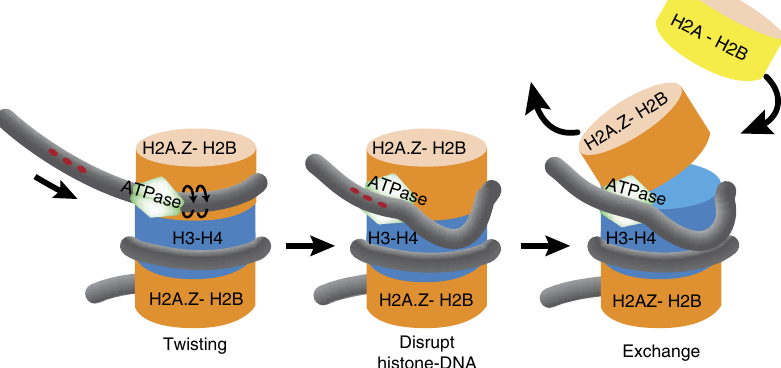
Figure 7 | INO80 translocates along DNA at the H2A–H2B dimer interface to displace DNA and promote H2A.Z exchange. A model showing DNA translocation by INO80 close to the DNA entry site of nucleosomes for nucleosome mobilization and histone dimer exchange. Translocation persistently destabilizes dimer–DNA interactions and promotes the exchange of H2A.Z–H2B Methods Enzyme purification . INO80 and ISW2 complexes were purified from Saccharomyces cerevisiae strains S288C 70 and YTT480 (ref. 71), respectively. Briefly, double FLAG epitope tags were inserted at the 3 0 -end of the INO80 and ISW2 genes and the complexes were purified by immunoaffinity chromatography using ANTI-FLAG M2 Affinity Gel (Sigma) and eluted with FLAG peptides. Complex purity and integrity was determined by analysing samples on 4–20% SDS–polyacrylamide gels. Enzyme complexes were tested for nucleosome binding, remodelling and nucleosome-stimulated ATP hydrolysis activity 36 . Nucleosome reconstitution . Mono-nucleosomes (‘70N0’ or ‘0N70’, N ¼ nucleosome core particle with 147bp of 601 DNA and number indicated length of extranucleosomal DNA) were assembled at 37 (cid:2) C by salt dilution with 7–10 m g of recombinant Xenopus laevis octamers (wild type or cysteine mutant octamer), 100–200fmol of 5 0 32 P-labelled 601 nucleosome-positioning sequence 57,72 containing DNA probes, 5–10 m g of sheared salmon sperm DNA (heterogeneous assembly) or polymerase chain reaction (PCR) amplified 601 DNA